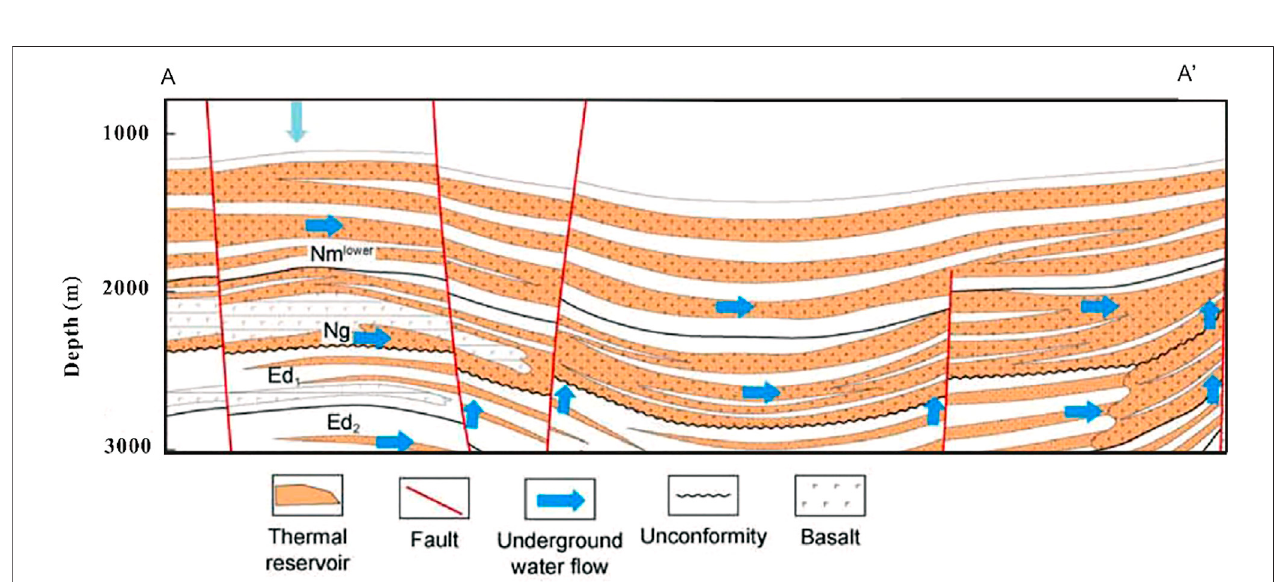
FIGURE 3 | Cross section (A,A 9 ) of the Nanpu Sag (cited from Huang et al., 2021b).